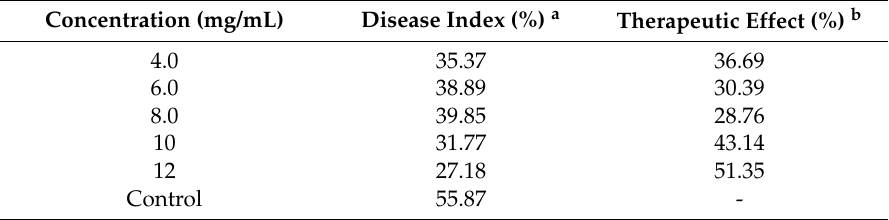
Table 9. Assay of the therapeutic effect of BAEO against Blumeria graminis